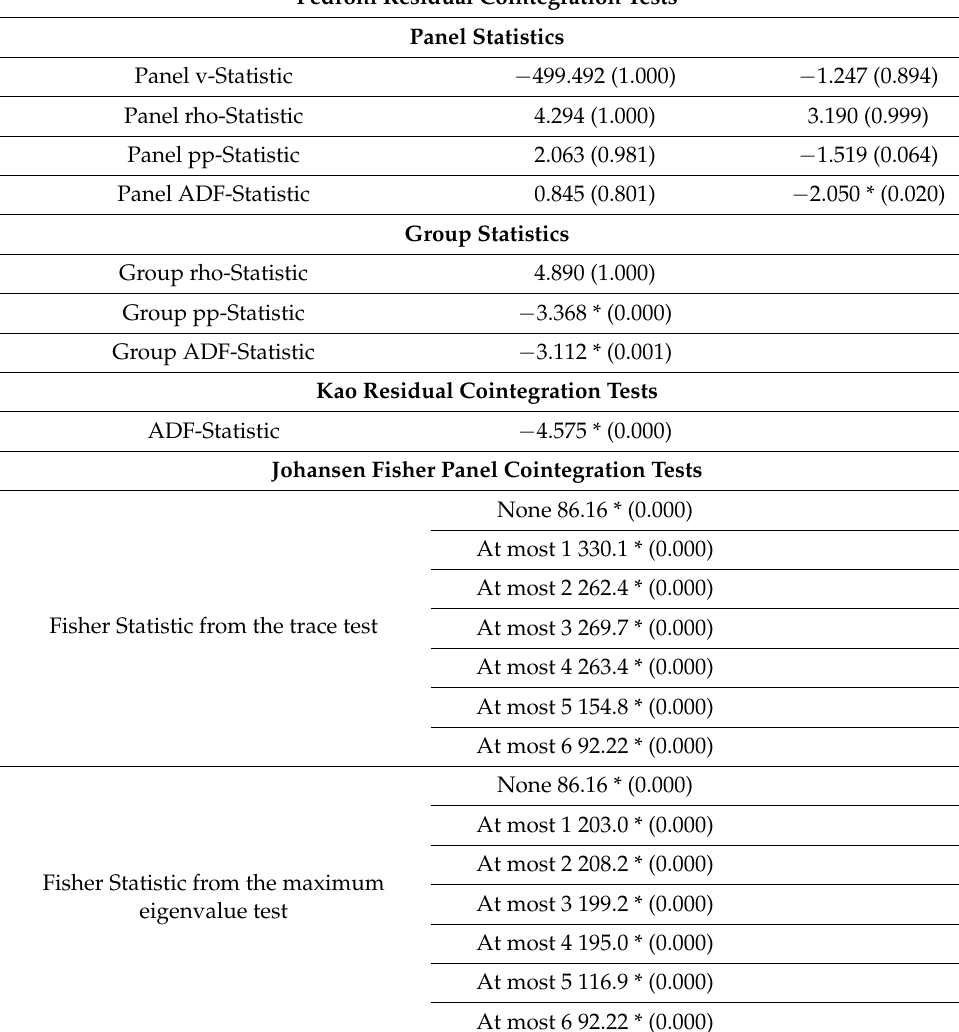
Table 2. Panel cointegration